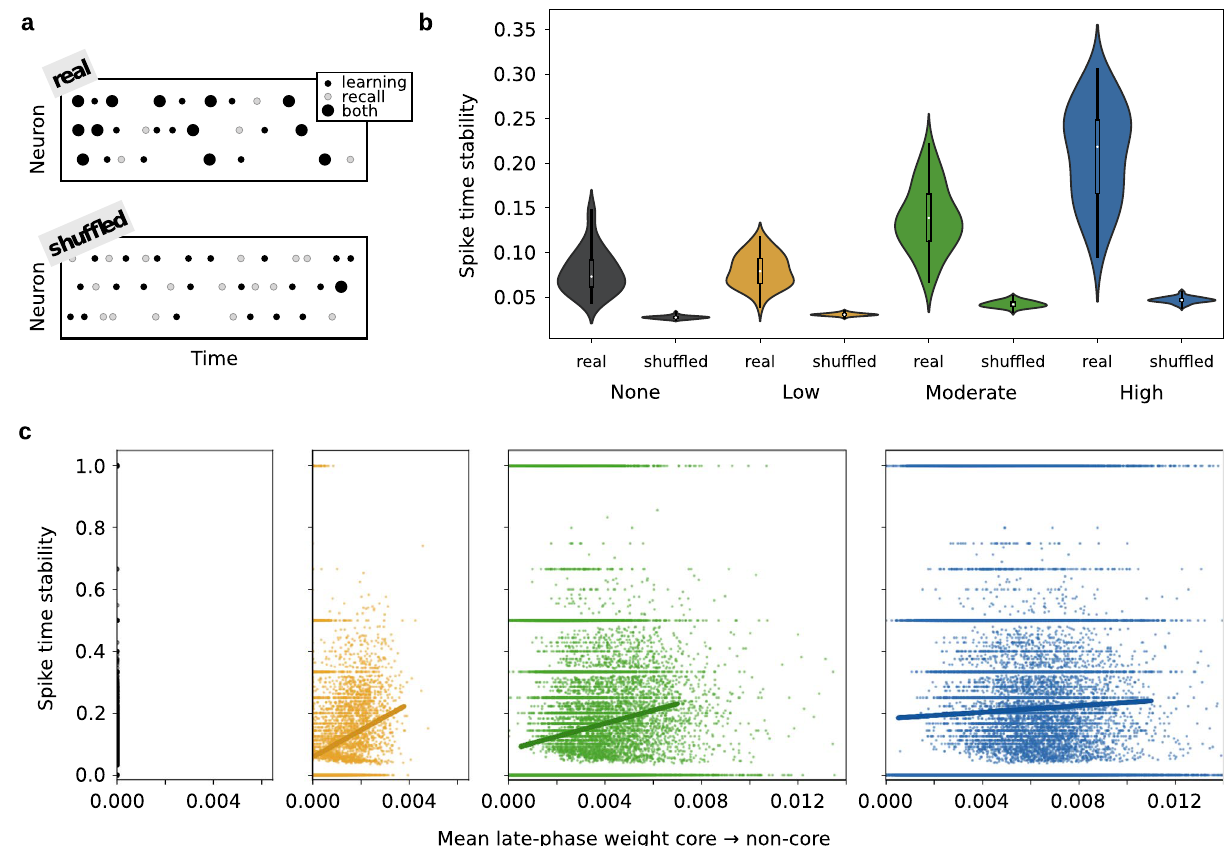
Figure 6. High level of neuromodulation during consolidation promotes spike time codes, particularly in support neurons. ( a ) Schematic of how spike time stability was quantified for real spike data versus shuffled data. Black points indicate the spikes during learning, light gray points the spikes during recall. Stable spike occurrence at the same time is indicated by large black circles. ( b ) Stability of spike times for the final learning stimulus pulse versus 8 h recall as a function of neuromodulator concentration for both real and shuffled data; learning stimulation frequency 60 Hz (i.e., gray, yellow, green, and blue stars from previous figures). Each violin plot contains an inset box-and-whisker plot showing median (white point), quartiles (black bar), and min to max (black line) across 50 network simulations. Kernel density estimates extend vertically beyond the extrema of the data and are normalized horizontally to have the same width. ( c ) Stability of spike times for non-core neurons as a function of mean late-phase weight from the core assembly, separated into none, low, moderate, and high neuromodulator concentration. Colors same as in (b) . Each point cloud contains data from 1450 neurons of 50 network simulations. Each point represents the mean late-phase weight of outgoing synapses from the core neurons to a specific non-core